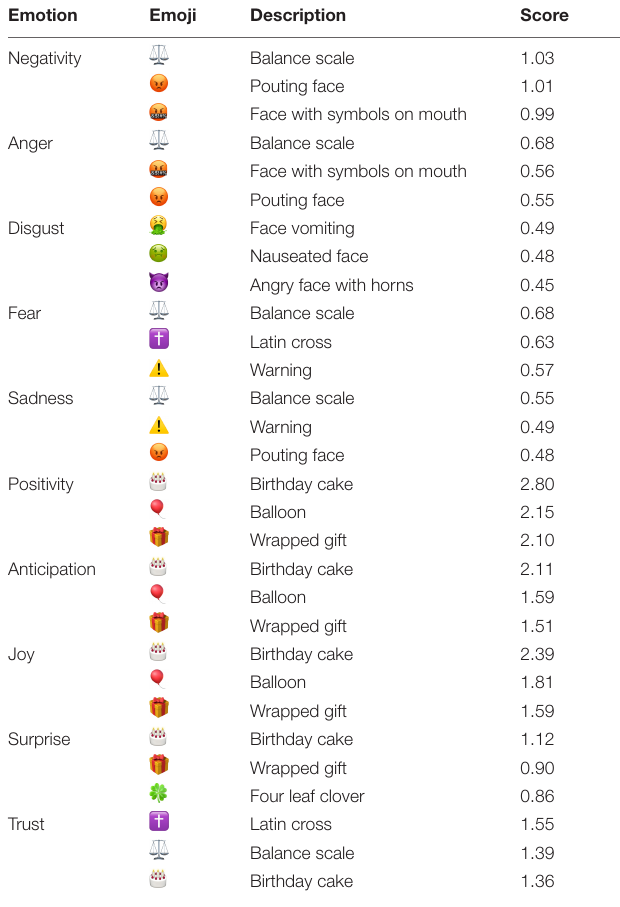
TABLE 1 | Emojis with highest scores on each